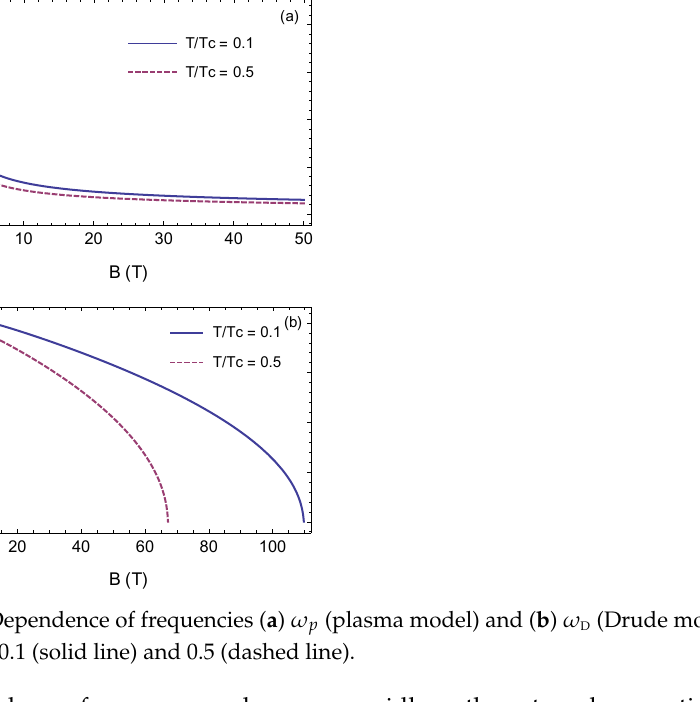
(Drude model) on magnetic D